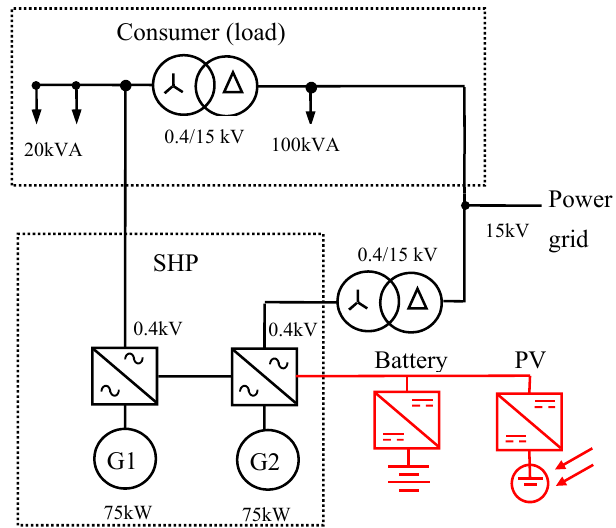
Figure 8. System topology of existing SHP and energy consumer (black) and proposed system expansion of PV and battery (red).